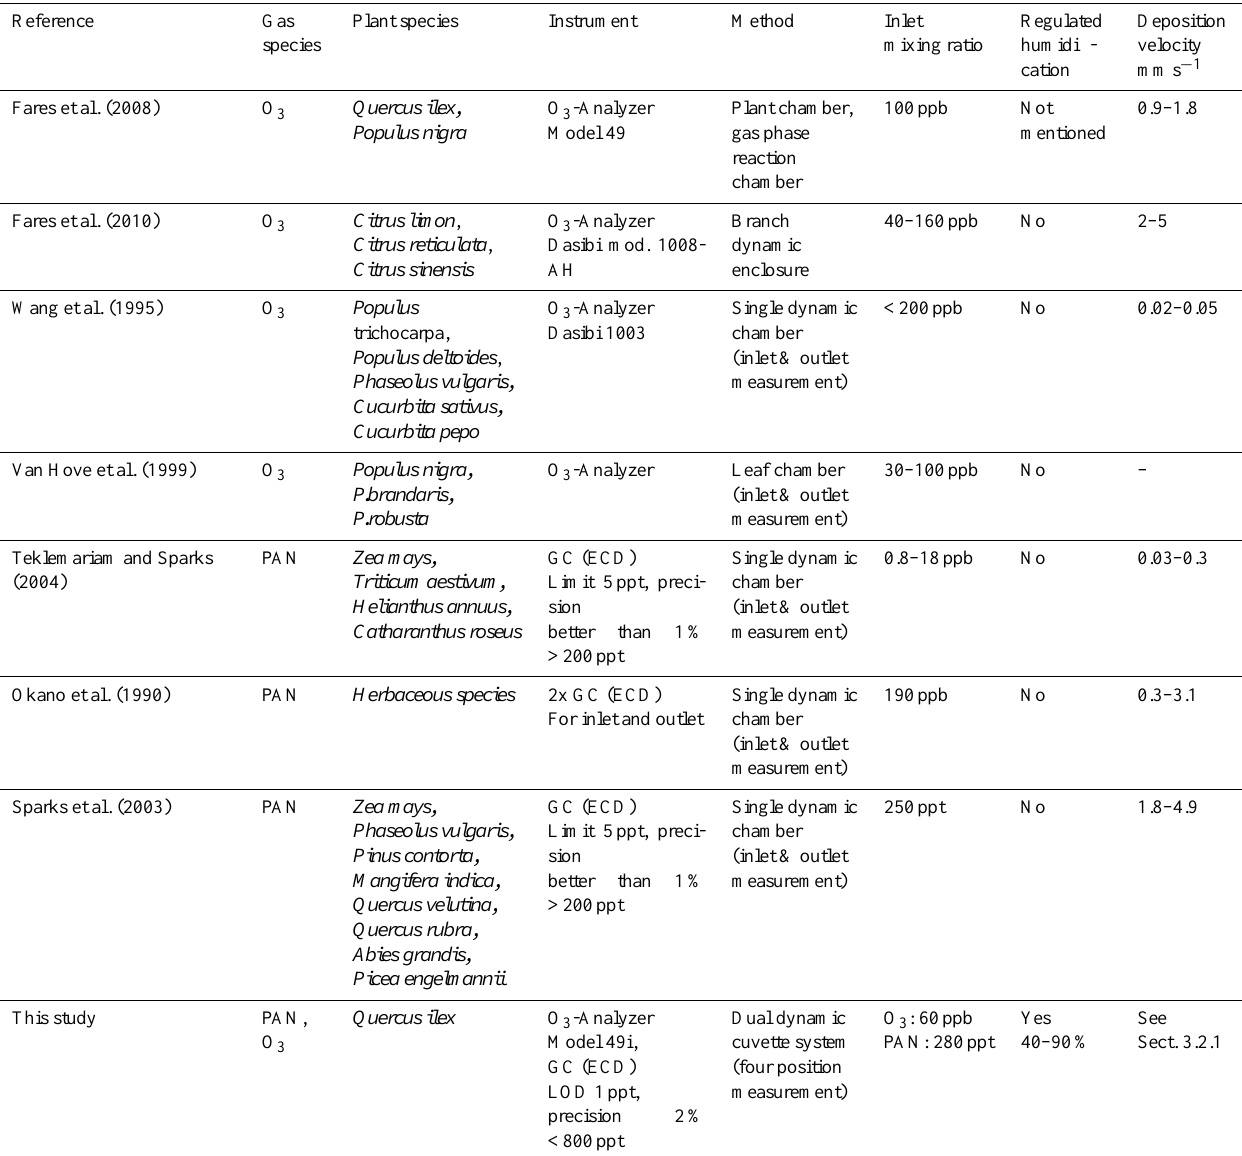
Table 1. List of previous studies in the research field of O 3 and PAN flux measurement on plants under laboratory conditions.